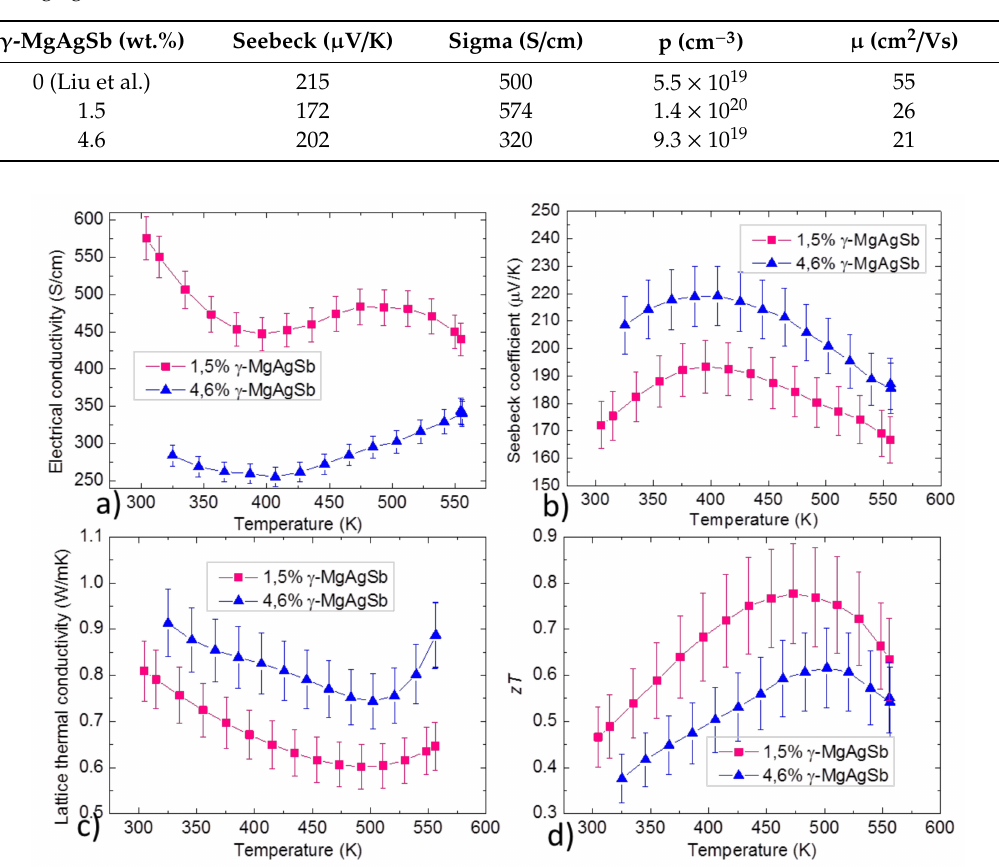
Table 6. Calculations of carrier concentration and mobility at room temperature for di ff erent γ -MgAgSb contents.